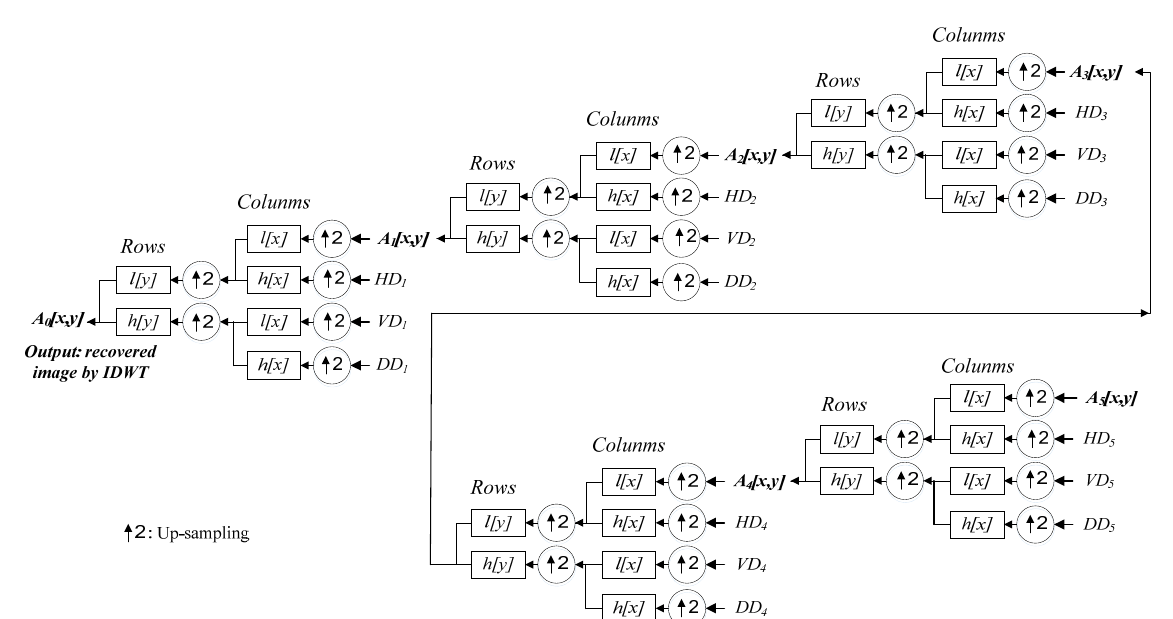
Figure 9. Five-level IDWT calculations employed in this work for finally obtaining the recovery images with pixel information (flowcharts of the IDWT decoding of each of the five levels).